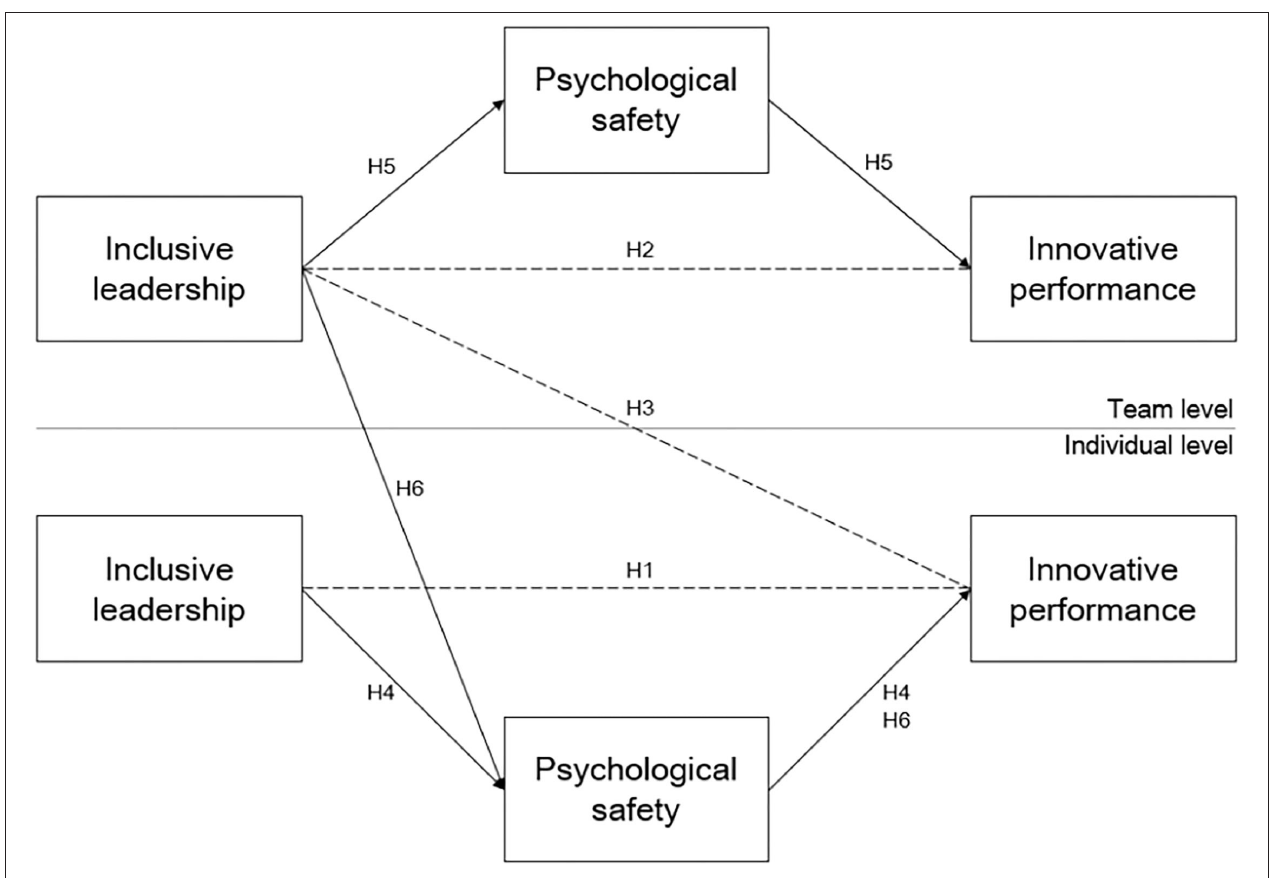
FIGURE 1 | Research